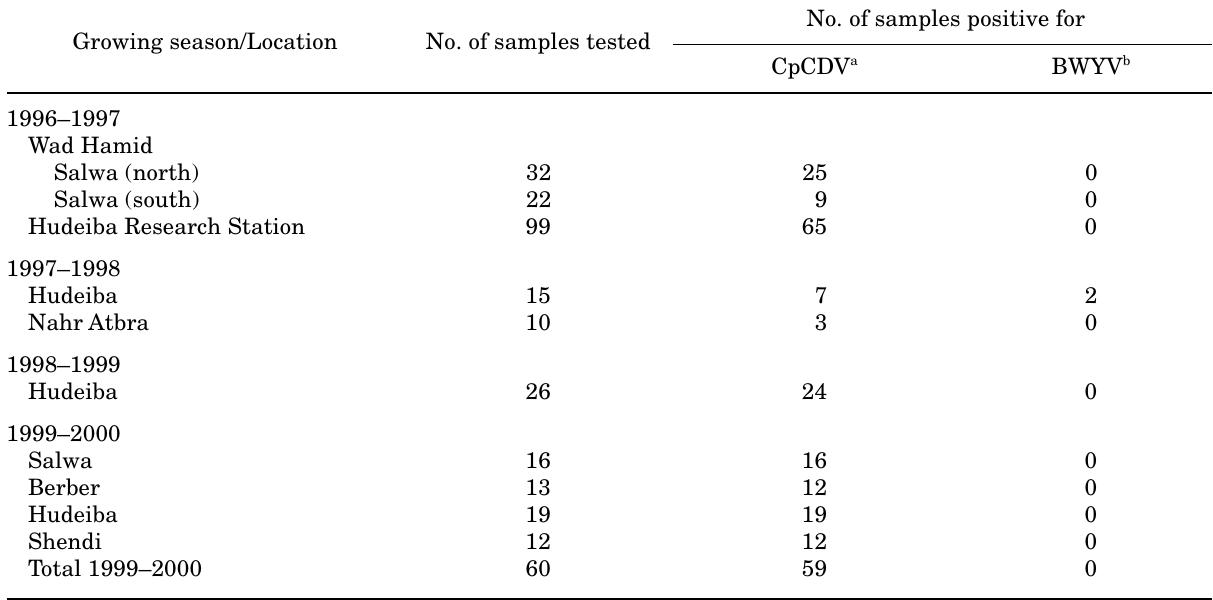
Table 2. Virus screening tests on 264 chickpea samples with stunting and yellowing symptoms, collected from fields in River Nile State, northern Sudan, in 1996–2000. Growing season/Location No. of samples tested